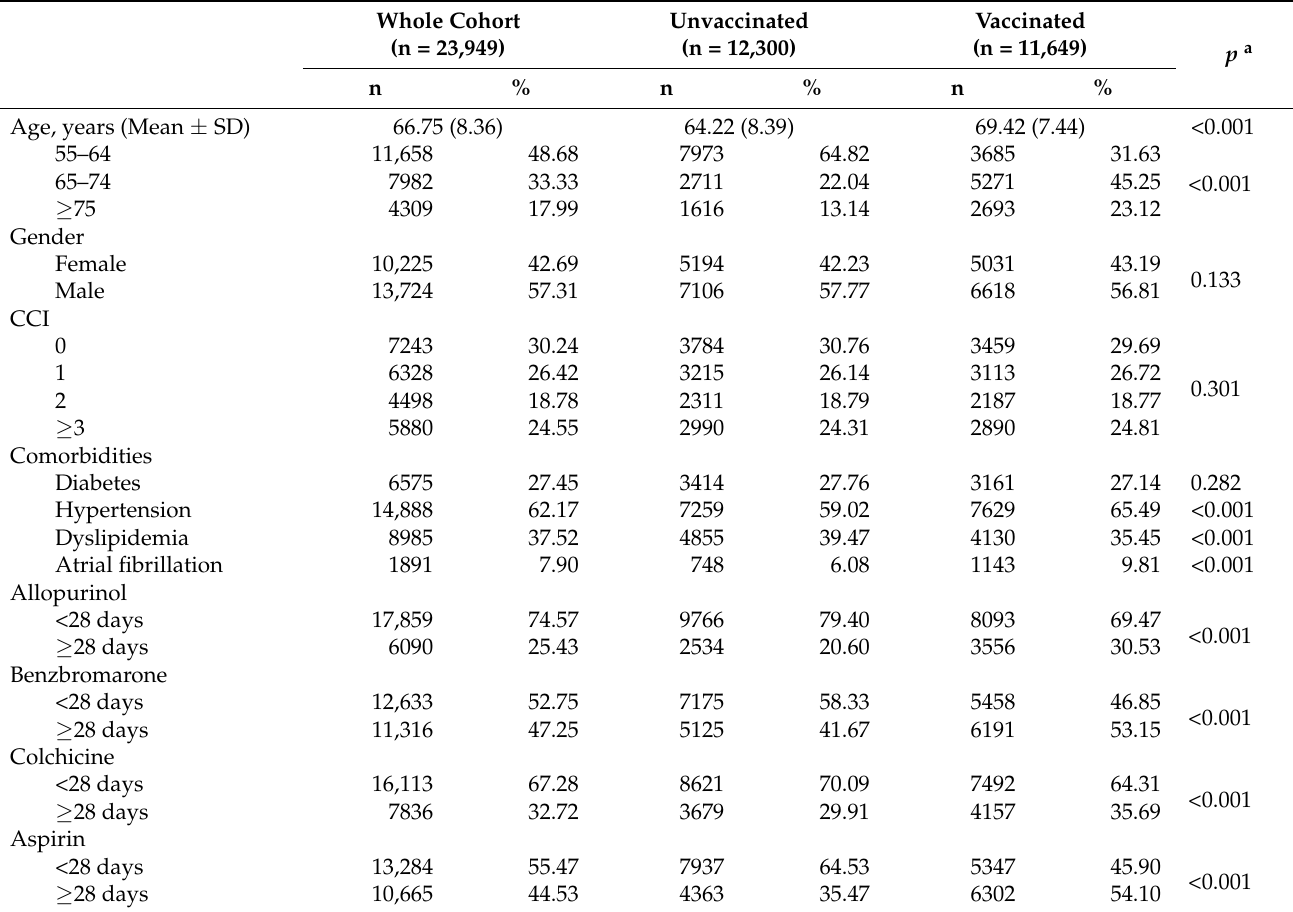
Table 1. Characteristic of the sample